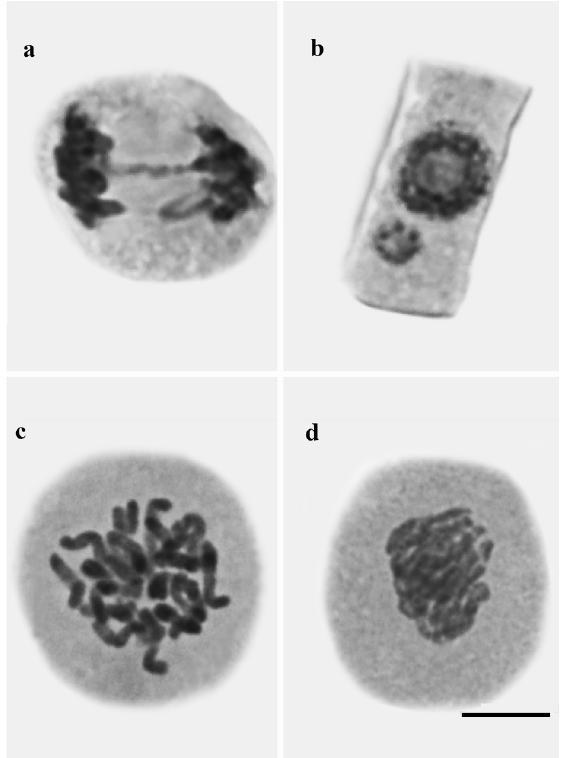
Figure 5. Cell cycle alterations observed in Lactuca sativa meristematic cells treated with five concentrations of triazoles 4a to 4k and positive control (picloram) and negative (water and dichloromethane). (a) bridge in anaphase, (b) interphase with micronuclei (c) C-metaphase (d) sticky chromosomes. Bar=10